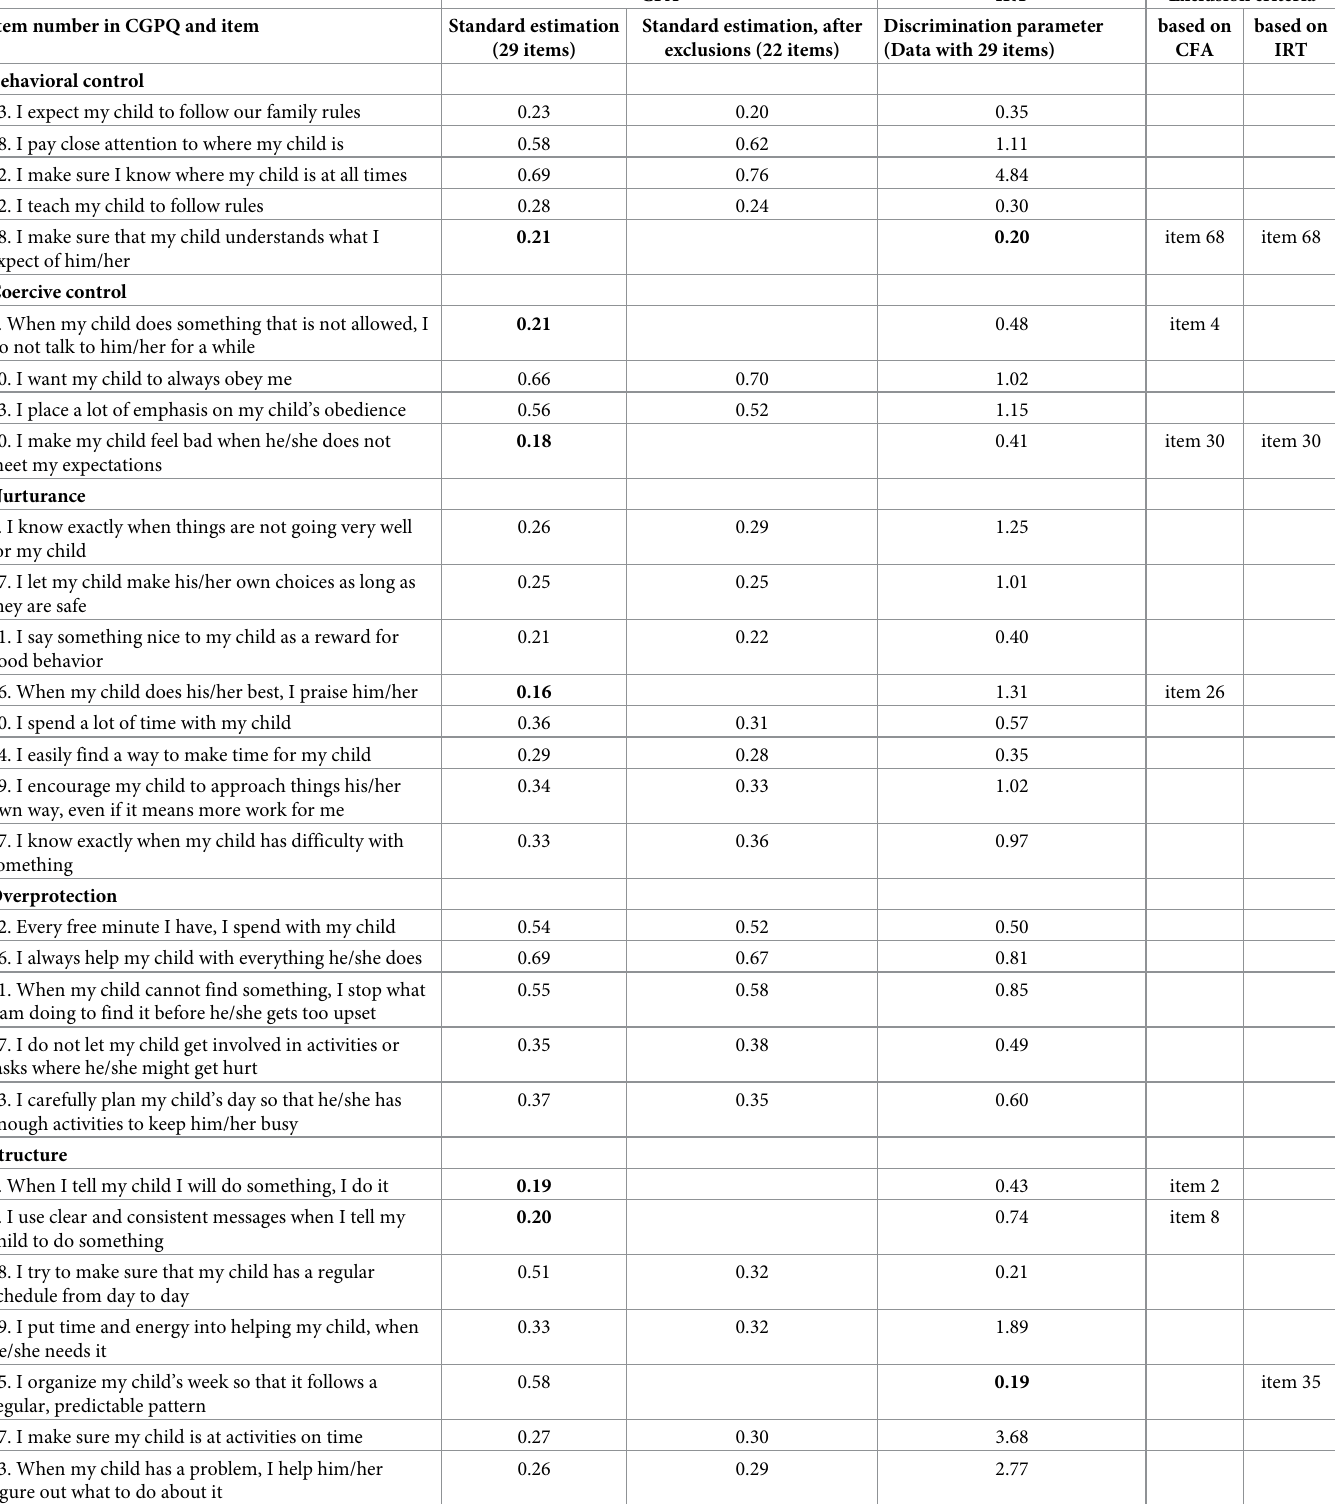
Table 4. Estimations and results of Confirmatory Factor Analysis (CFA) and Item Response Theory (IRT) in Study 1